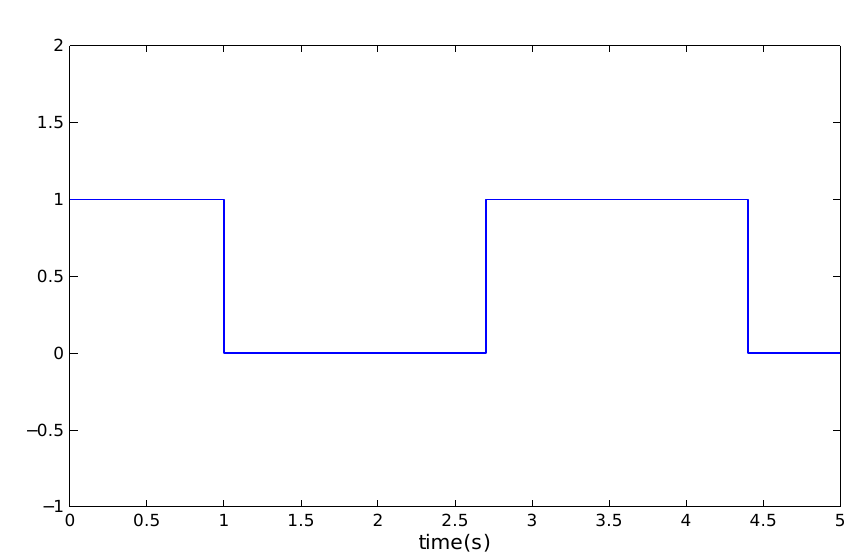
Fig. 4. Switching signal of system (5) with